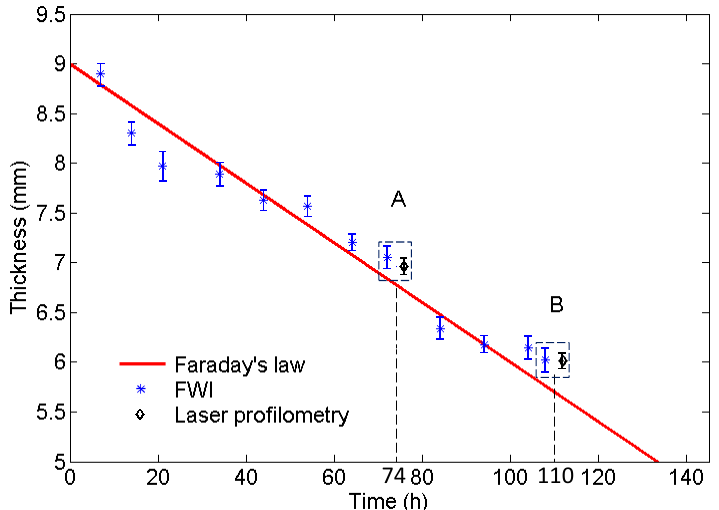
Figure 6. The comparison of the average reconstructed thickness of the defect obtained by full waveform inversion (FWI) at 60 kHz and predictions by Faraday’s law in different corrosion periods of a mild steel plate. The upper and lower limits of measured thickness of defect A and B at corrosion time of 74 and 110 h obtained by FWI and laser profilometry are shown in the rectangular boxes, respectively. The results of laser profilometry will be explained in Section